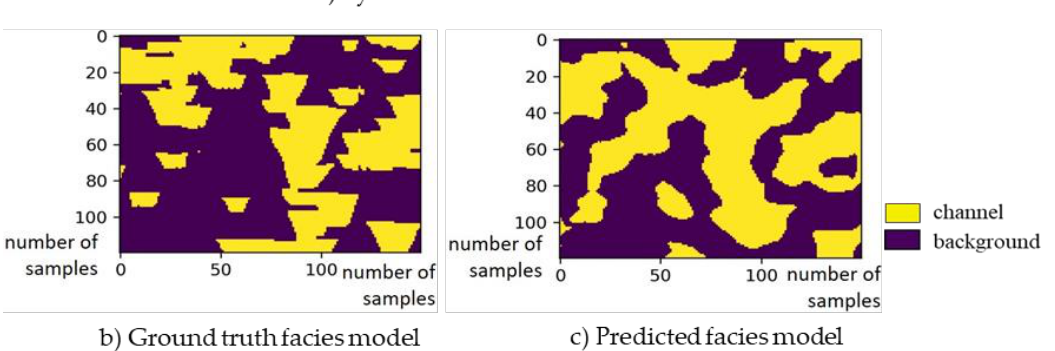
Figure 23. Synthetic seismic section ( a ), ground truth facies model ( b ) and predicted result ( c ). U- Net was trained on the entire training set. The prediction is very close to the true facies model.